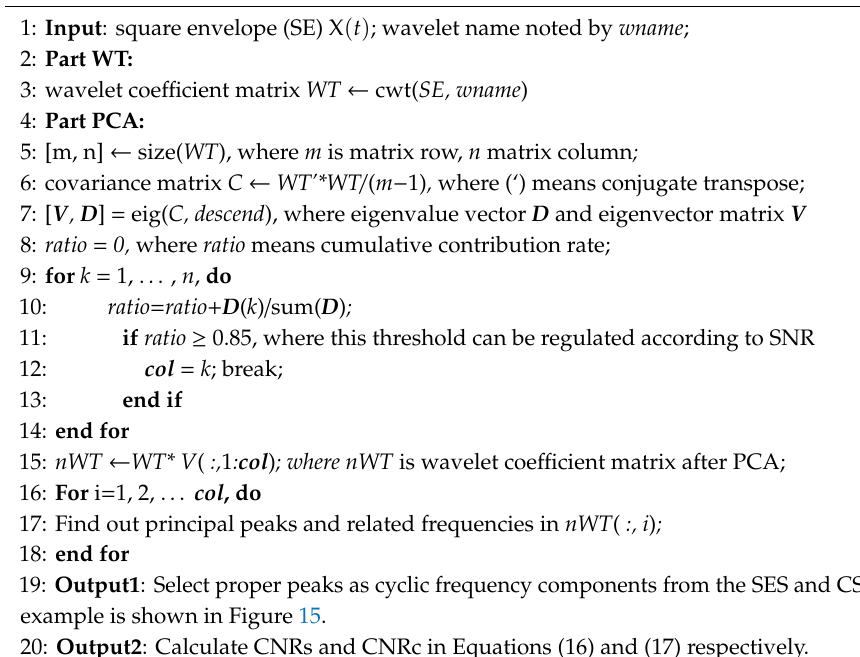
Algorithm 1: Principal component analysis (PCA) selection of cyclic frequencies for the character to noise ratio (CNR) calculation